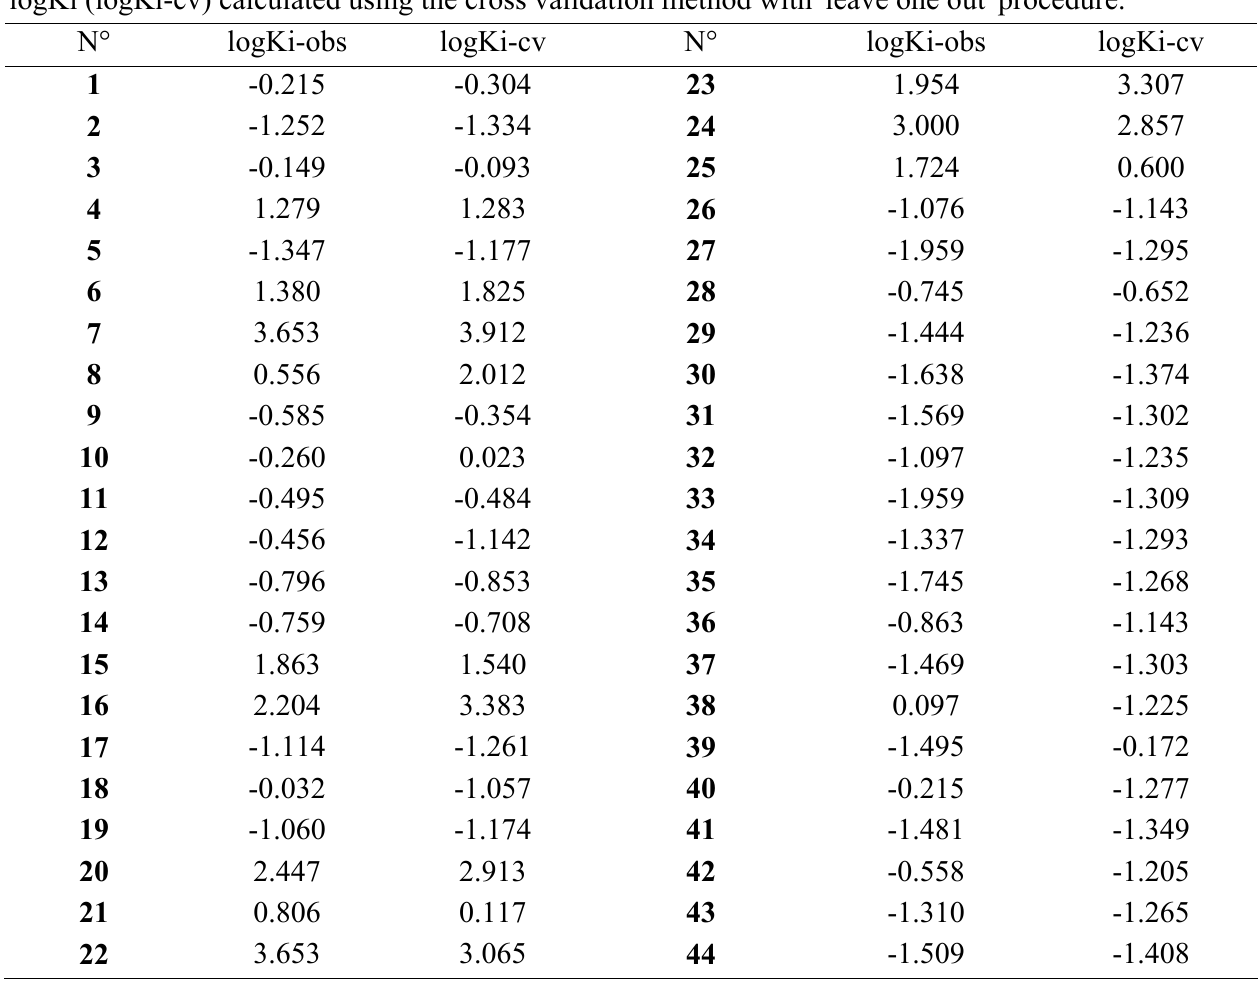
Table 4. Values of observed logKi (logKi-obs) corresponding to reference [4], and values of predicted logKi (logKi-cv) calculated using the cross validation method with 'leave one out' procedure.